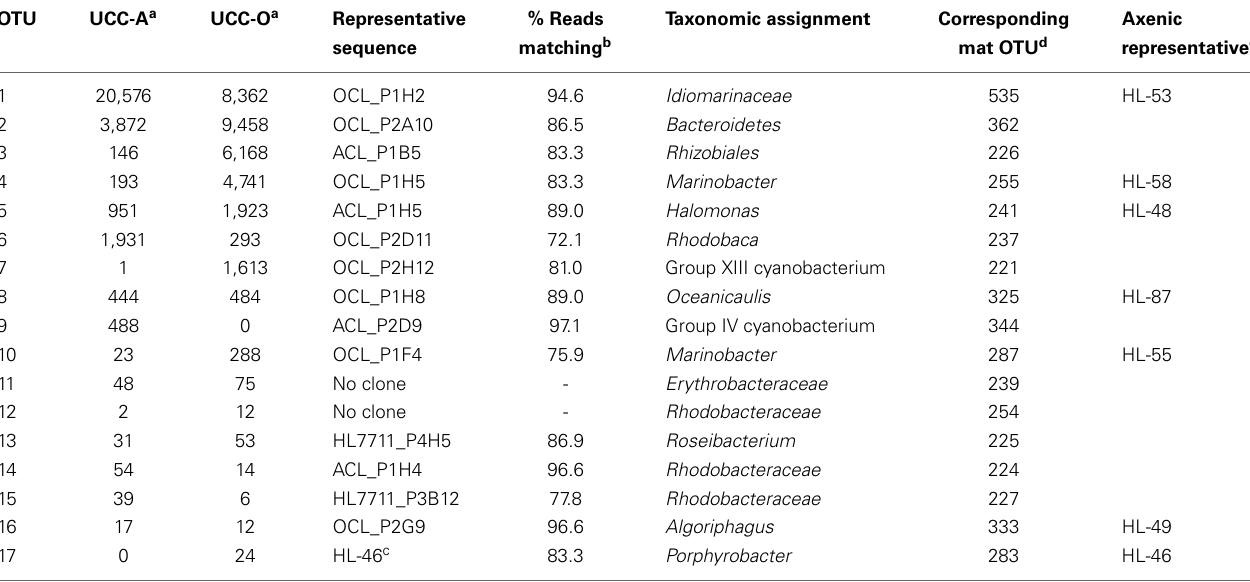
Table 2 | Members of the consortia as determined by amplicon